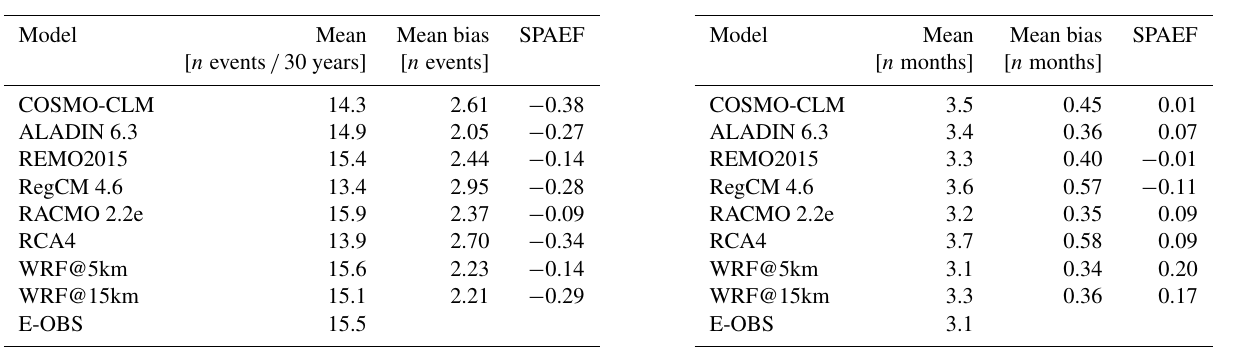
Table 7. Drought frequency SPEI-3 metrics. Table 8. Mean drought duration SPEI-3